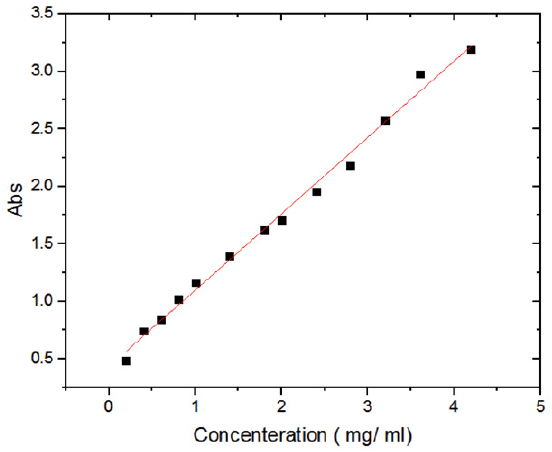
Figure 10. The calibration carve of DOX adsorption